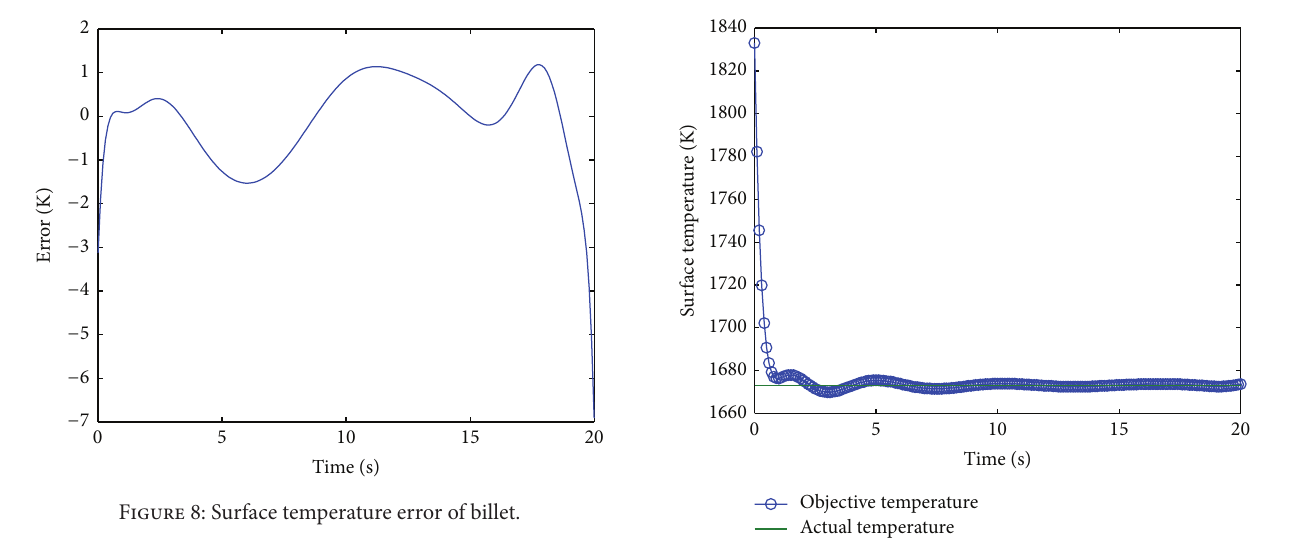
Figure 10: Surface temperature of billet.